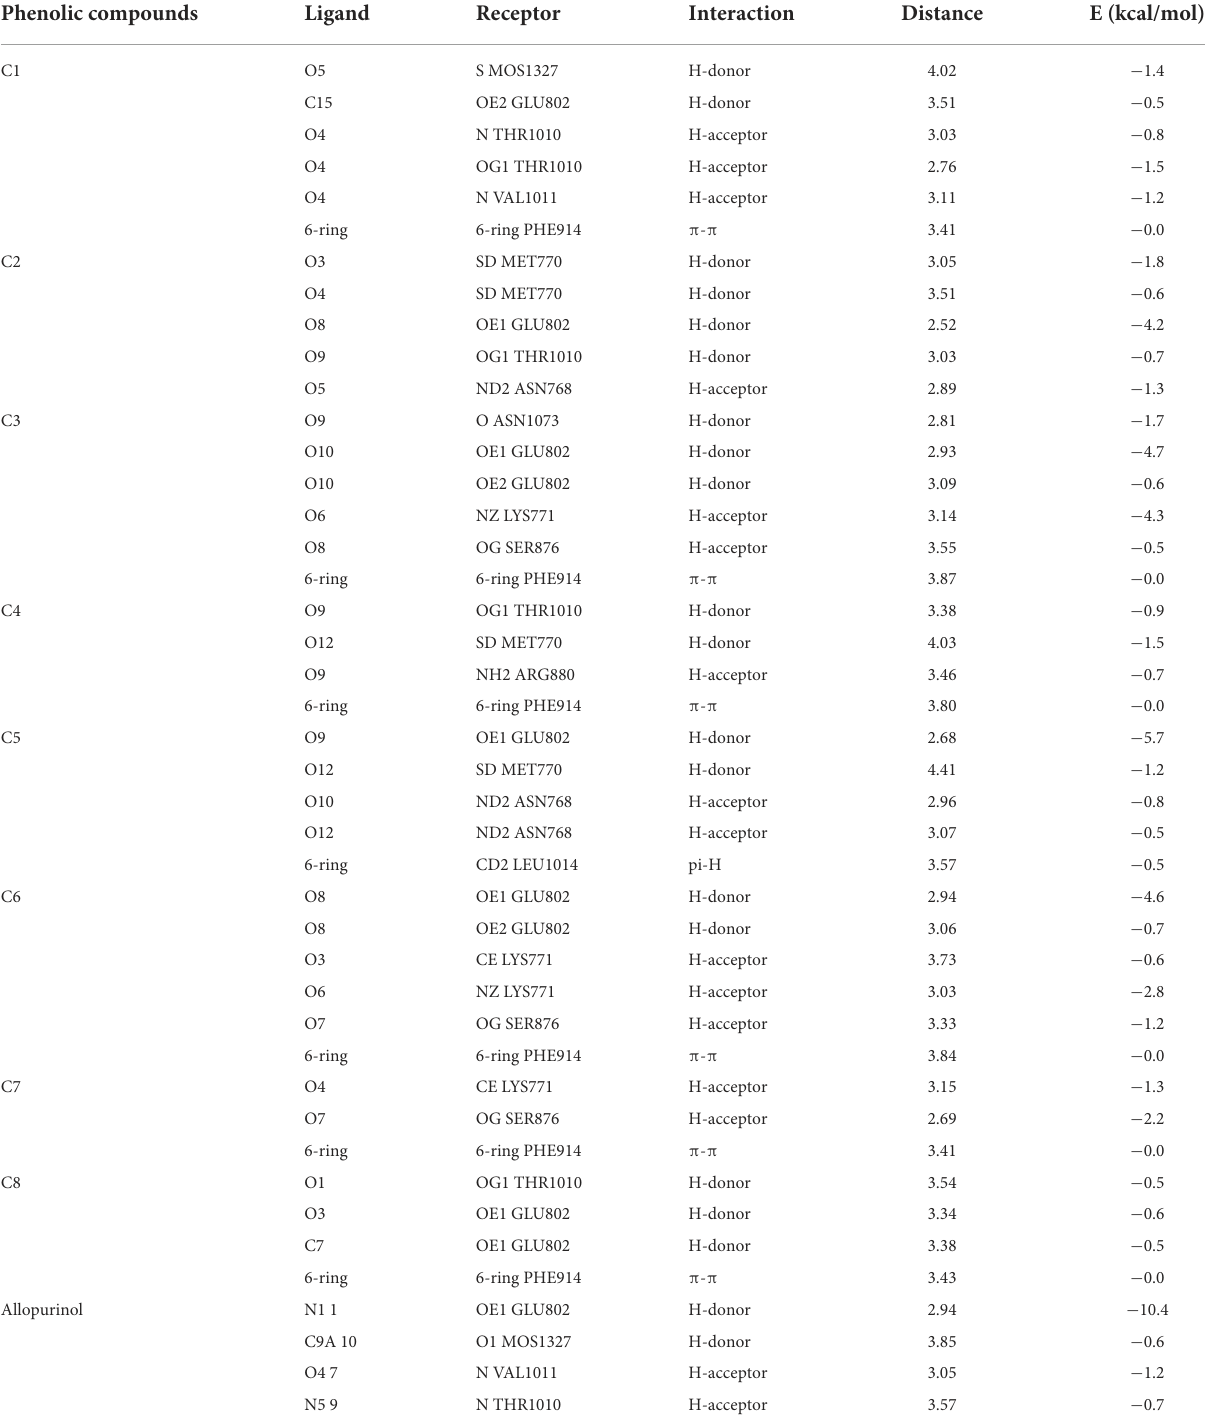
TABLE 2 Interaction detail of phenolic compounds with xanthine oxidase enzyme. Phenolic